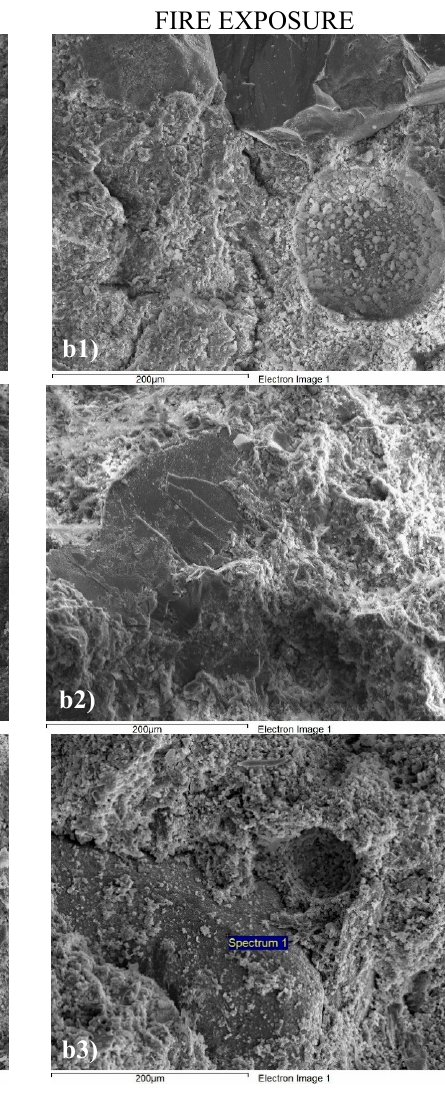
Figure 7. Compression testing to breaking point in test pieces without addition and with 1% CNFs, before and after fire testing. Appl. Sci. 2020 , 10 , x FOR PEER REVIEW